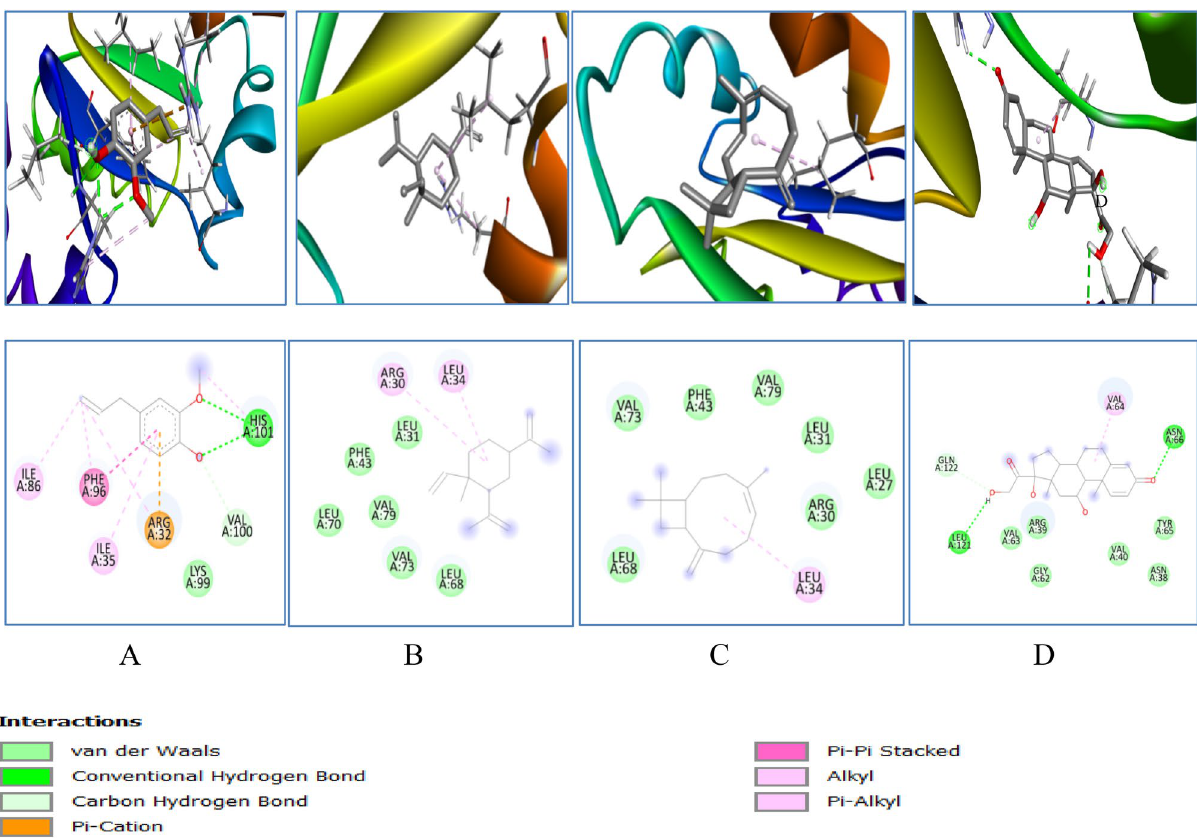
Figure 13. 3D (to the upper panel) and 2D (to the lower panel) interaction diagrams of ( A ) Eugenol, (B) Cyclohexane ( C ) Caryophylleine ( D ) Prednisolone with the crystal structure of Glutathione Reductase (PDB ID: